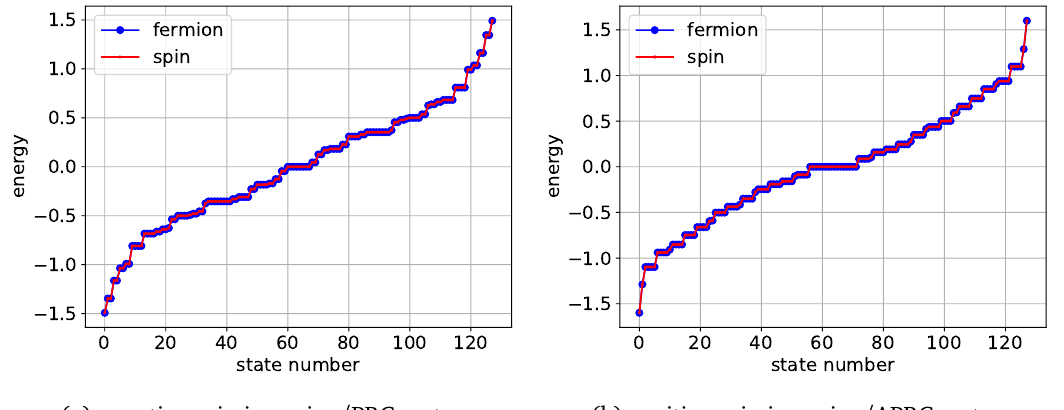
Figure 1: Comparison of the spectra [ in units of J ] of the spin (1) and fermion (3) representation of the transverse field Ising Hamiltonian. The degeneracy in the spec- trum is due to the remaining reflection and translation symmetries which could easily be taken into account (see text). The parameters are J = 1.0, h =